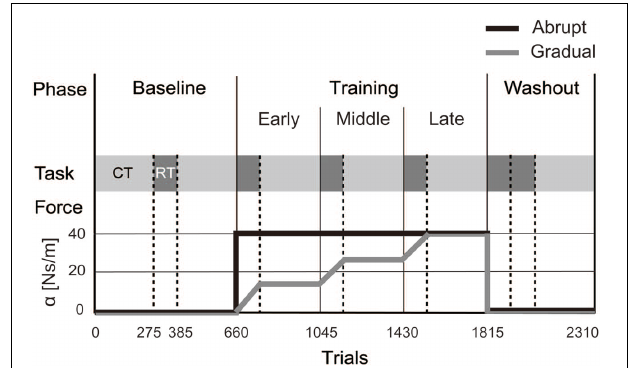
FIGURE 2 | Training Schedule. Upper row: the experiments consisted of 3 different phases: the baseline, training, and washout phases. Middle row: each phase consisted of the choice test (CT; light gray) and the reach training (RT; dark gray). Lower row: The force field was applied either abruptly (black line) or gradually (gray line). All participants performed the task under both conditions in a crossover design.